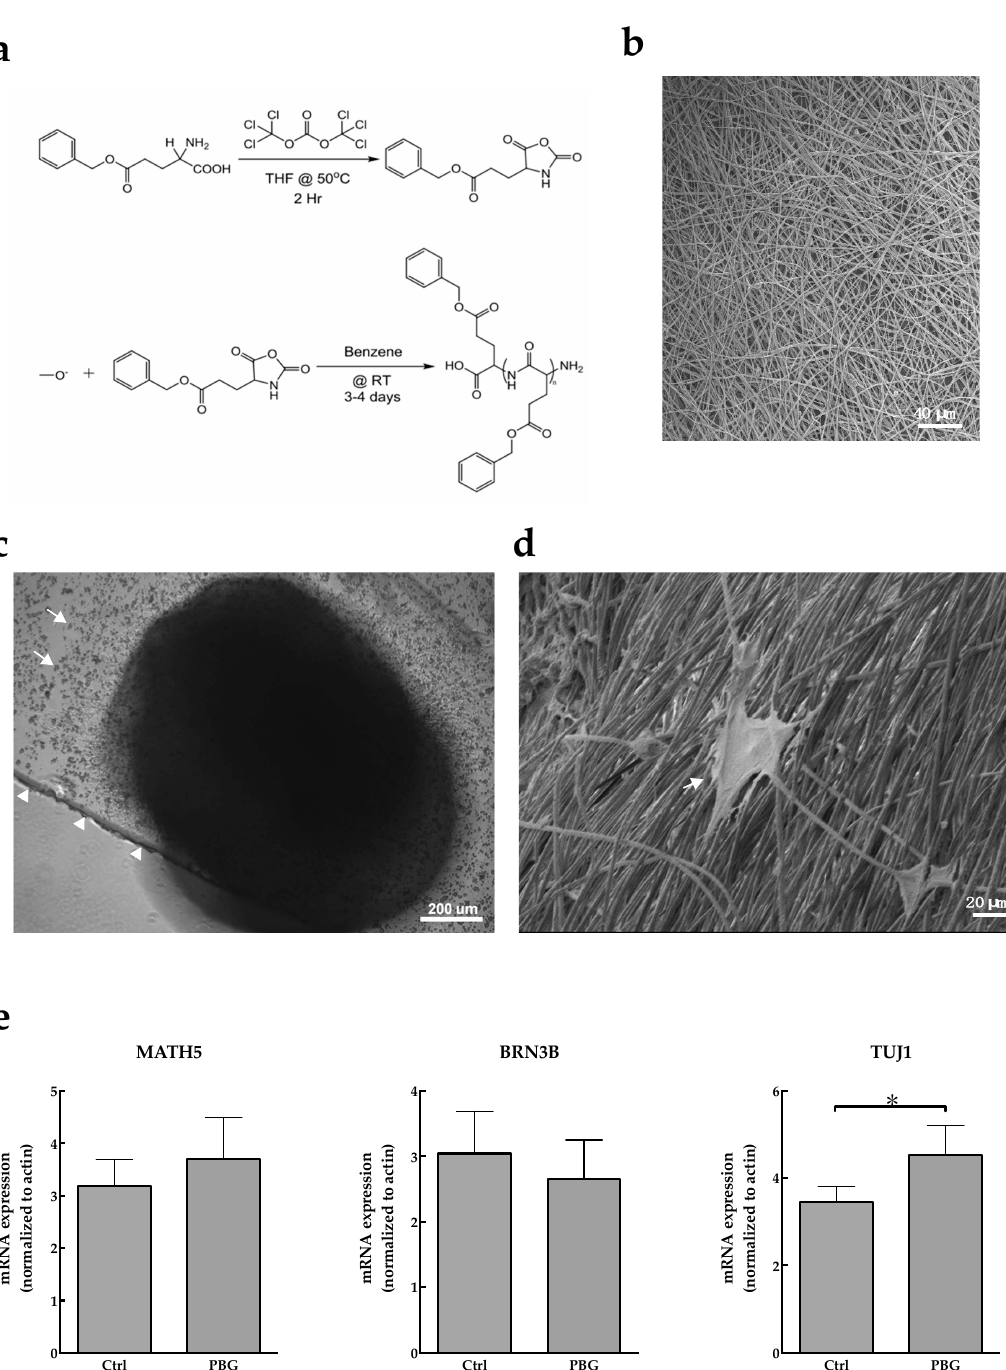
Figure 2. Induction of hiPSC differentiation to RGC-like cells on polybenzyl glutamate (PBG) scaffold. ( a ) Synthetic scheme of polyglutamate of PBG. ( b ) Scanning electron microscope (SEM) image of PBG scaffold. Scale bar = 40 µ m. ( c ) The image of iPSC-derived RGC-like cells cultured on the PBG scaffold (arrow) was recorded by phase contrast microscope on Day 34. The arrowheads indicate the edge of glass cover. Scale bar = 200 µ m. ( d ) SEM image of hiPSC-derived RGC-like cells (arrow) on the PBG scaffold, and the neurite was adhesive grew on the PBG scaffold. Scale bar = 20 µ m. ( e ) The mRNA expression of MATH5 , BRN3B , and TUJ1 in hiPSC-derived RGC-like cells cultured on cover glass (Ctrl) or PBG scaffold (PBG) on Day 34. Values are presented as mean ± SEM, n = 3, * p < 0.05.